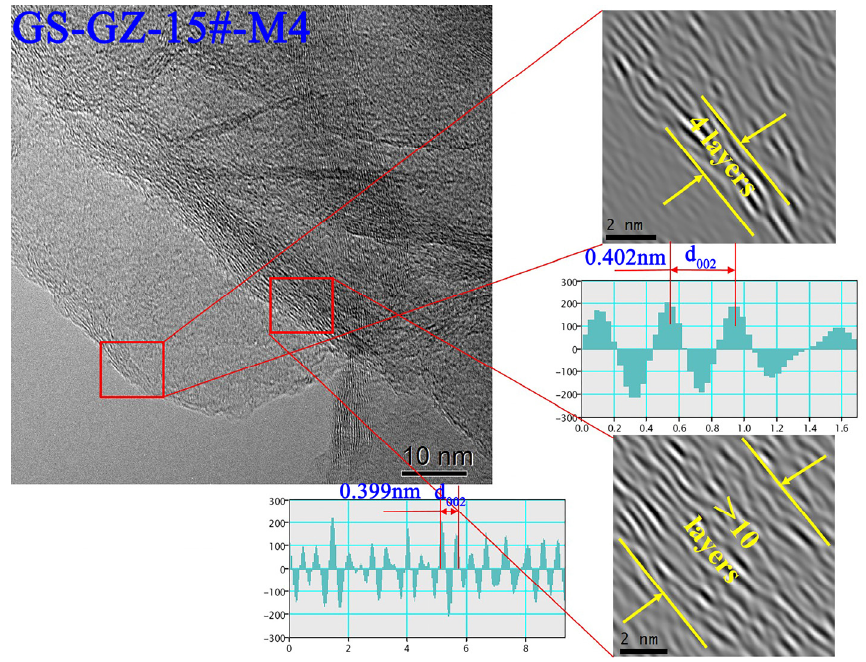
Figure 17. HRTEM comparison image between the edge and middle of coal graphene layers.